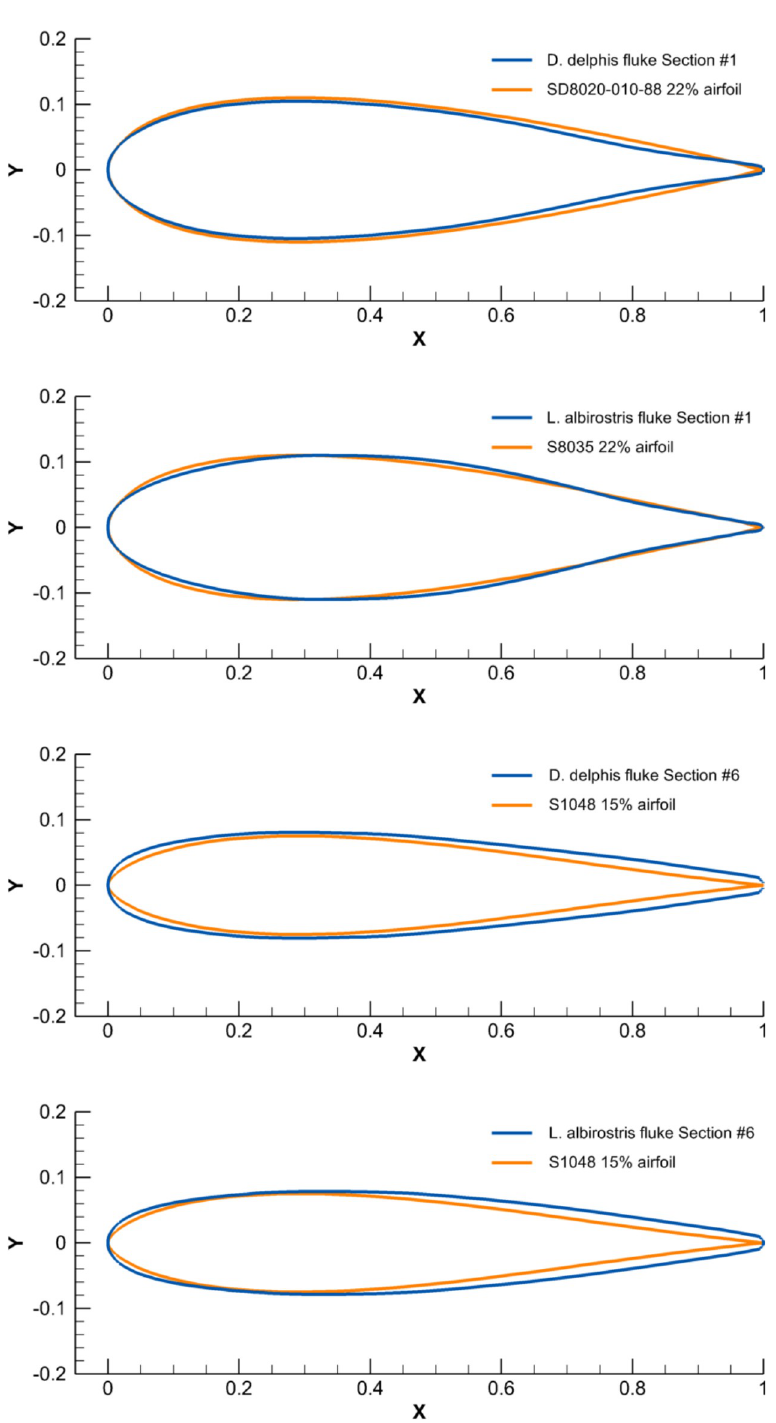
Fig 9. Comparison of the chord-normalized profile coordinates of cross-sections taken at the base and top of tail flukes of the selected species with the conventional airfoils. parameters of the fin shape were found to be correlated except for the sweep Λ of the fin which showed a negative correlation with AR (Table 5).